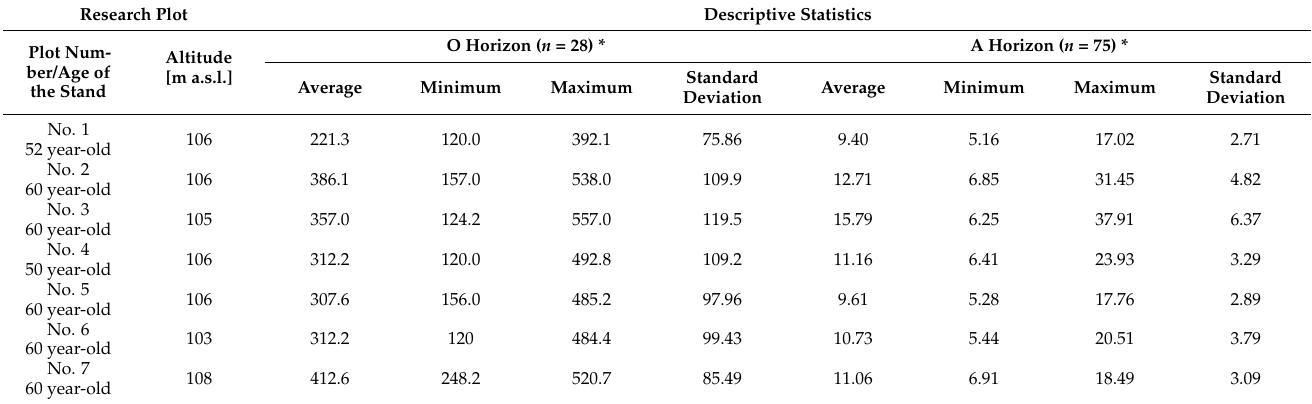
Table 1. Organic carbon content in the O and A horizons in g · kg − 1